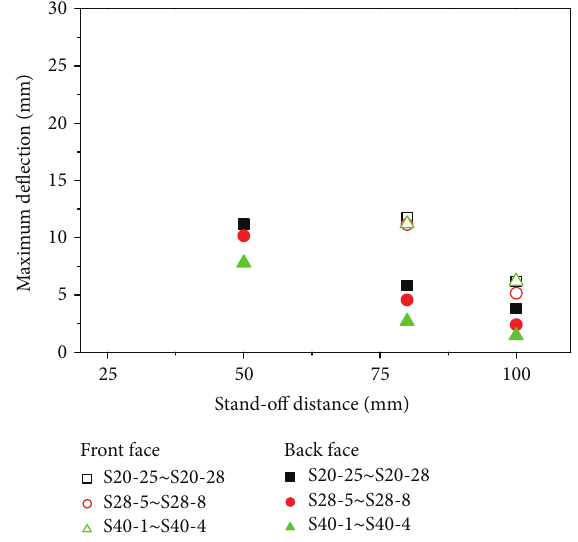
Figure 19: Maximum deflections of sandwich panels with the same relative density (5.46%).